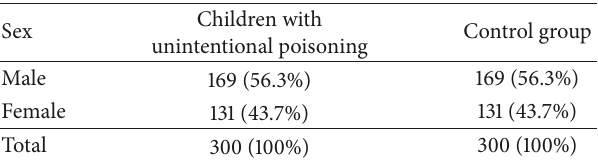
Table 3: Sex distribution of the two groups with “acute poisoning” and